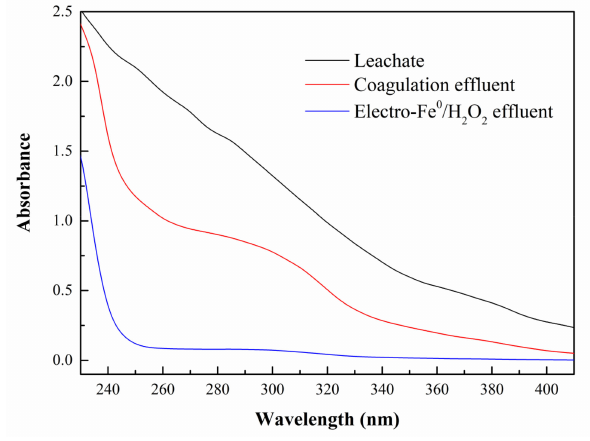
Figure 6. The UV-vis spectra of leachate, coagulated effluent, and electro-Fe 0 /H 2 O 2 . Table 2. Special absorbance values for different leachate